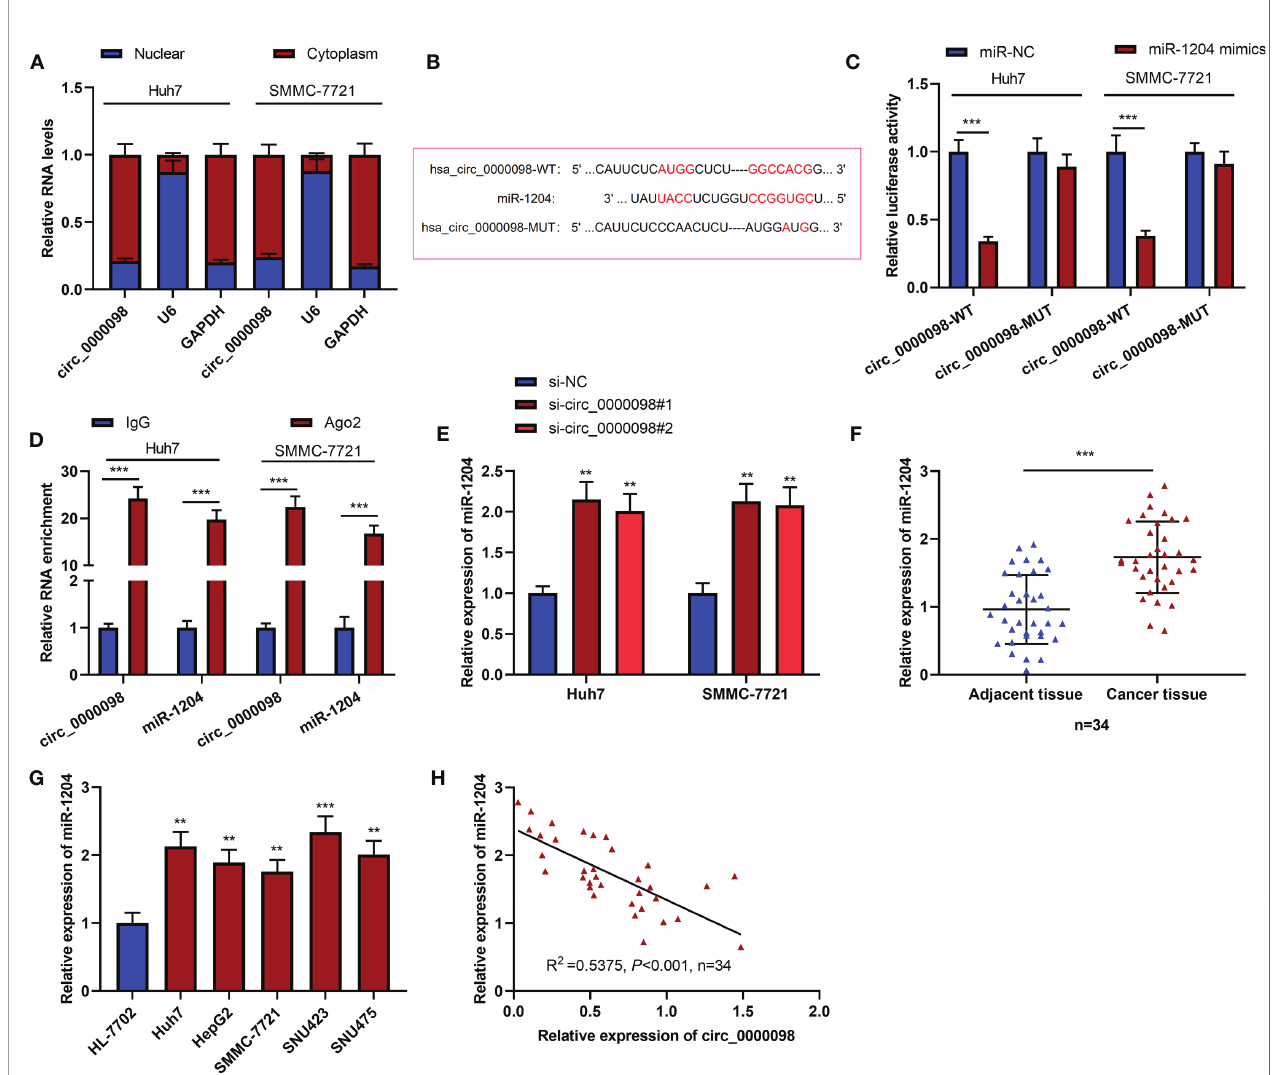
FIGURE 3 | MiR-1204 was the target of circ_0000098. (A) qRT-PCR was used to detect the expressions of circ_0000098, U6, and GAPDH mRNA in the nucleus and cytoplasm of HCC cells. (B) The binding sequence between miR-1204 and circ_0000098 was predicted by Circular RNA Interactome database. (C) Dual- luciferase reporter assay was used to verify the binding relationship between miR-1204 and circ_0000098. (D) The direct interaction between circ_0000098 and miR-1204 was determined by RIP assay. (E) qRT-PCR was used to detect the expression of miR-1204 in cells transfected with si-circ_0000098#1 and #2. (F, G) The expression of miR-1204 in HCC tissues and cells was detected by qRT-PCR. (H) Pearson ’ s correlation analysis was used to analyze the correlation between miR-1204 and circ_0000098 expressions in 34 HCC tissues. ** P < 0.01 and *** P <